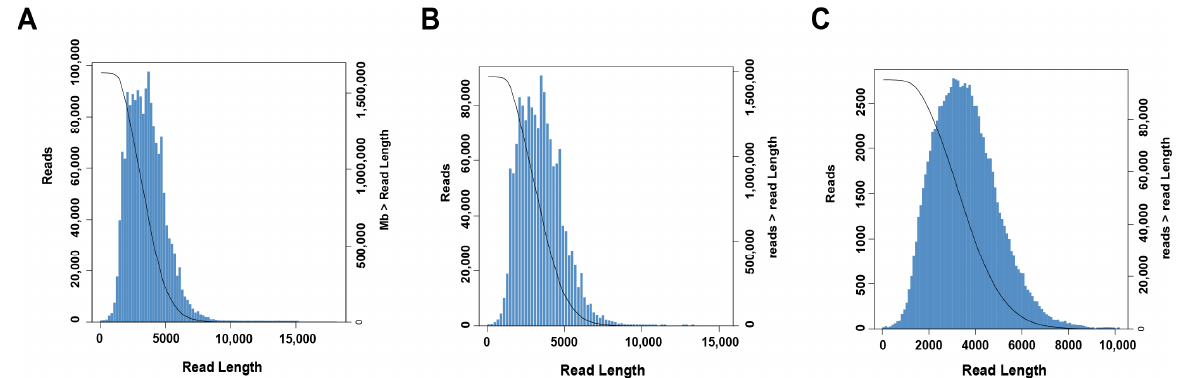
Figure 1. Sequel full length transcriptome cDNA library construction, data processing, and bioin ‐ formatic analysis.